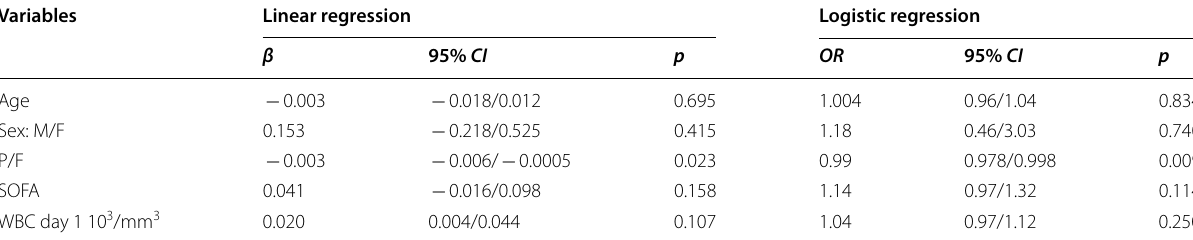
Table 4 In both linear and logistic multivariate analyses, P/F was significantly and inversely related to KL-6 Variables